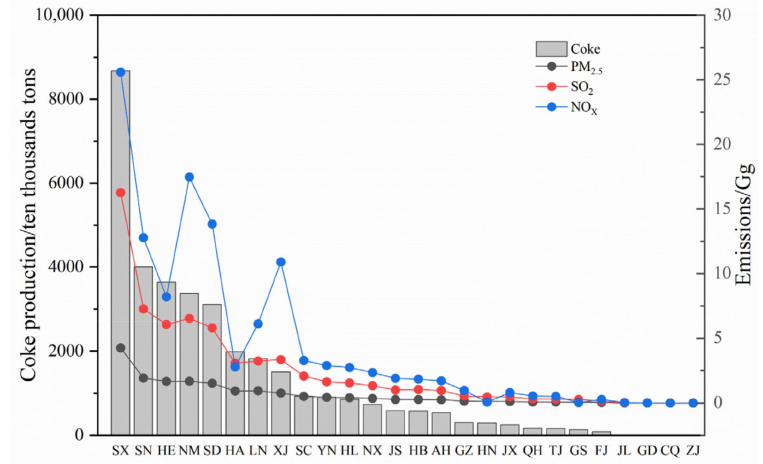
Figure 4. Provincial production of coke and emissions of SO 2 , NO X , and PM 2.5 of China’s independent coking industry in